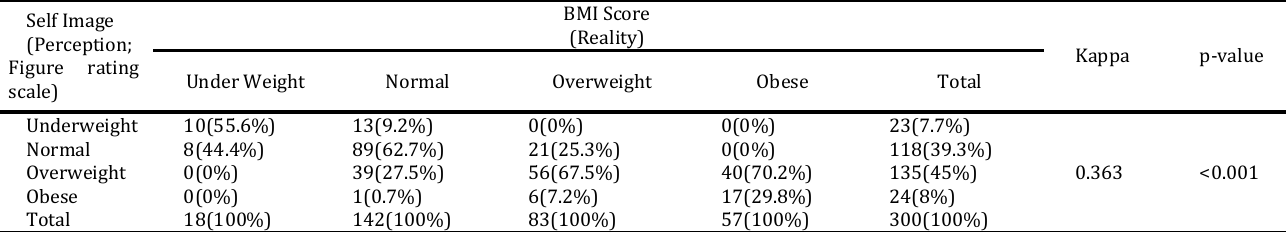
* P-value significant at or less than 0.05